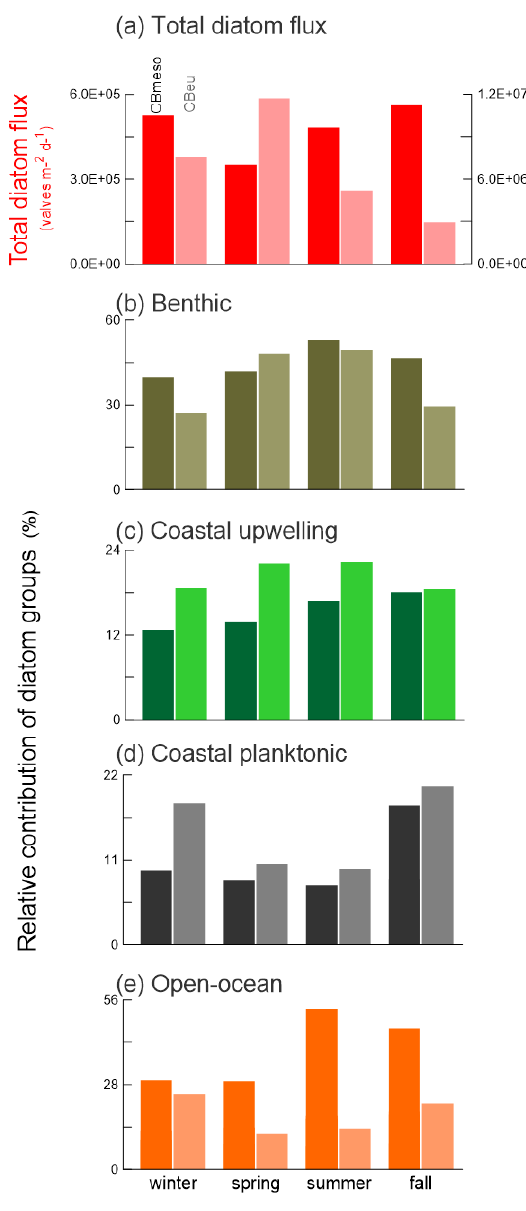
Figure 7. Comparison of seasonal values of (a) total diatom flux (valves per square meter per day) and (b–e) the relative contribution of diatom groups (%) at the sites CBmeso and CBeu (see Sect. 2.1 for trap locations). Darker colors represent flux and relative percent- age at CBmeso, while lighter colors show those of CBeu. Note that the right y axis for (a) total diatom flux corresponds to CBeu, and the left-hand y axis corresponds to the CBmeso site. For the species- specific composition of each group at CBmeso, see Sect. 4.2. and Table 2. The species-specific composition of groups at CBeu was originally published in Romero and Fischer (2017). Colors used for identifying each diatom group are the same as in Fig. 2b. For inter- pretation of the references to color in this figure legend, the reader is referred to the web version of this